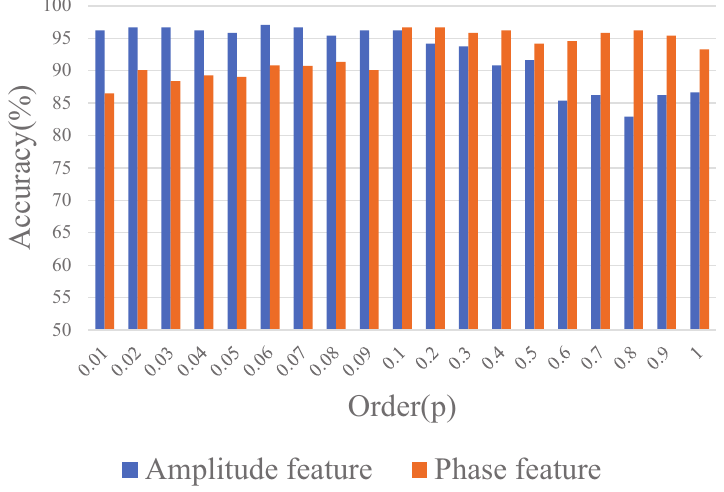
Figure 9. Classification results of Amplitude and Phase features under different orders using the BCCT200-resize data.